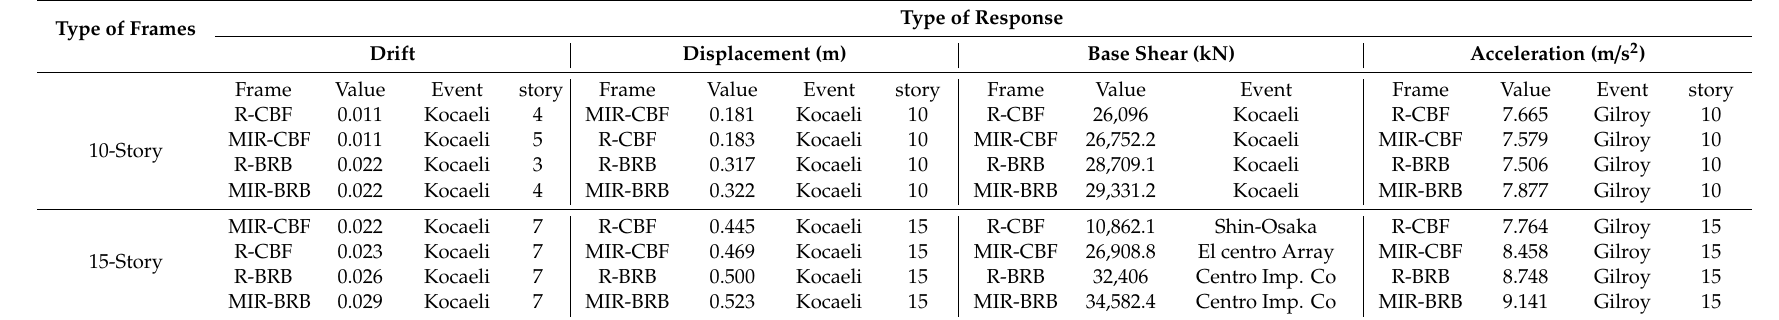
Table 5. Maximum amount of seismic evaluation